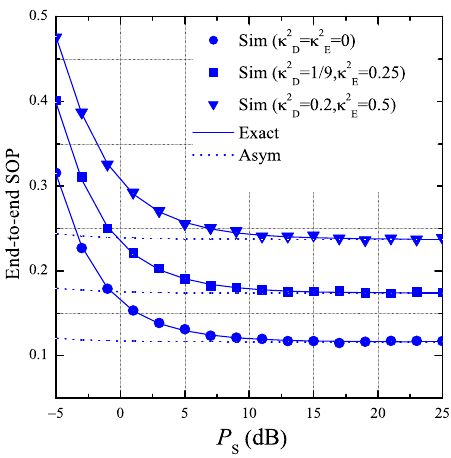
= 0, and κ 2 = 0.01. D E